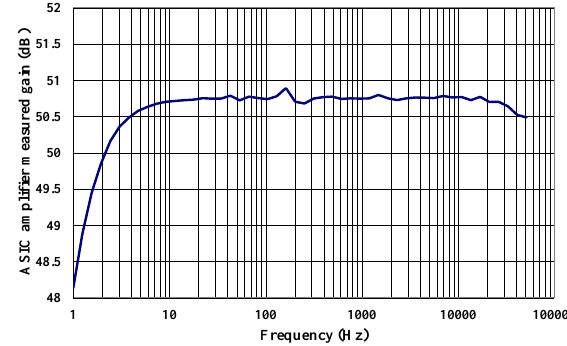
Figure 4. Amplifier transfer function (in dB) of MAGIC2.